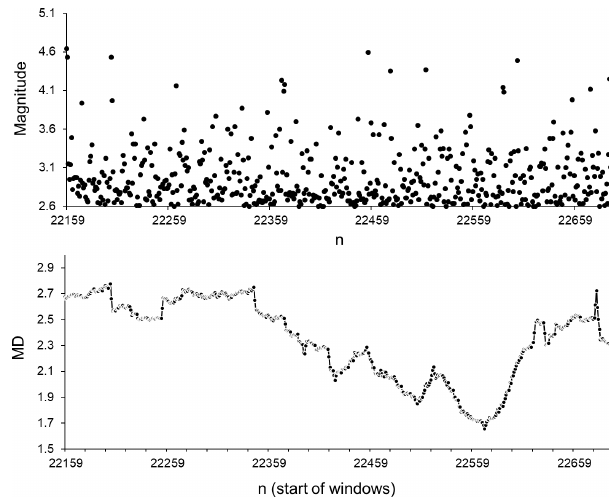
Figure 11. Magnitudes and MD values calculated for part of the SC catalogue after M 7 . 1 (16 October 1999, sequential number in SC catalogue 21937) from 16 October 1999 (sequential number in SC catalogue 22159) to 21 October 1999 (sequential number in SC catalogue 22697). Average MD values are calculated for 50-data windows shifted by one data step; 92% of earthquakes in this pe- riod occurred within a distance of 1.2–60km from the epicentre of M 7 . 1.